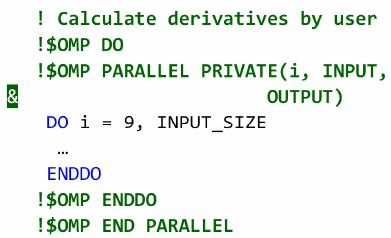
Figure 7. Scheme of Parallel user finite forward difference method, illustrating the parallelization of the sensitivity analysis of the subroutine for deformation-related measurements.